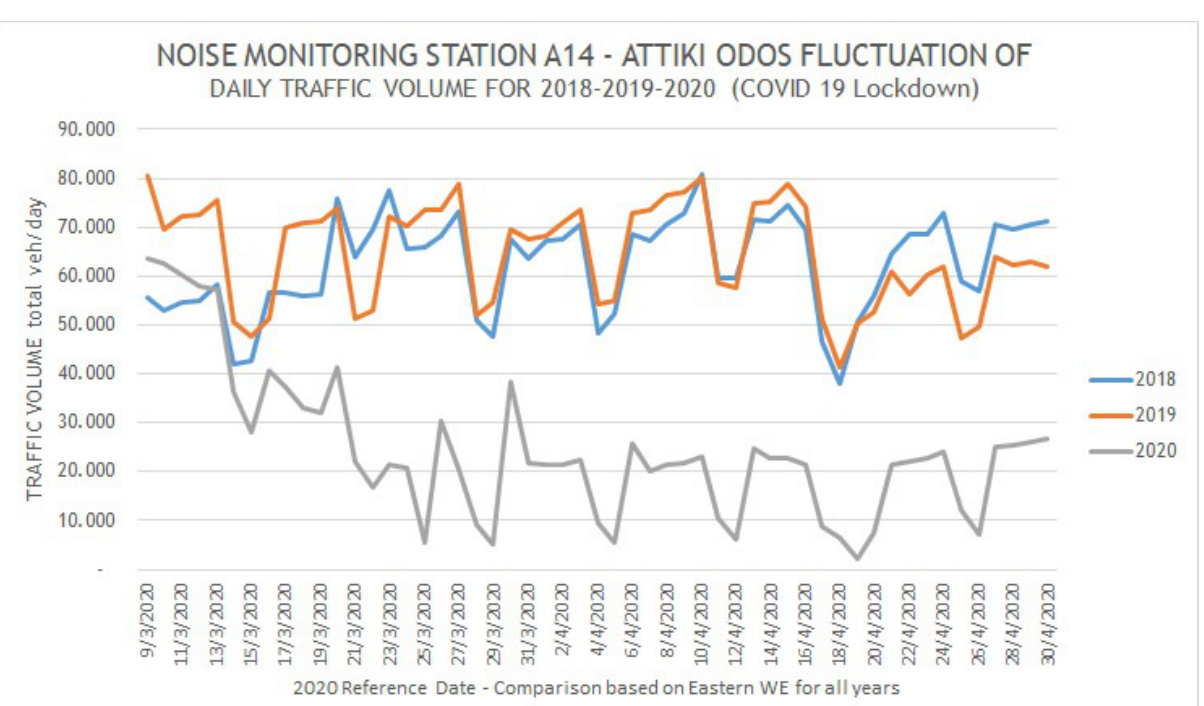
Figure 8f: Daily traflc volume – Noise monitoring station